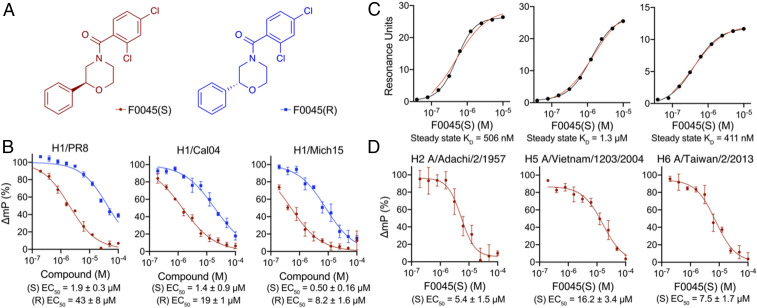
Characterization of F0045 enantiomers. (A) Chemical structures of F0045(S) and F0045(R). (B) Dose-response comparison (200 nM to 100 μM) of F0045(S) and F0045(R) binding a panel of H1 HAs as measured by the FP P7-TAMRA probe competition assay. The assay consisted of a solution of PBS, pH 7.4, 0.01% Triton X-100) and a 75-nM P7-TAMRA probe and H1 HA (30-nM H1/PR8, 30-nM H1/Cal04, and 100-nM H1/Mich15) mixed for several seconds at room temperature prior to measuring FP. DMSO and 300-nM P7 peptide represent the negative and positive controls, respectively. FP was measured in triplicate. (C) Steady state kinetic dose responses of F0045(S) (200 nM to 250 μM) against H1 HAs (H1/PR8, H1/Cal04, and H1/Mich15) as measured by SPR. (D) Dose-response comparison of F0045(S) binding a panel of group 1 HAs (50 nM for H2 A/Adachi/2/1957 and H5 A/Vietnam/1203/2004 and 55 nM for H6 A/Taiwan/2/2013) measured as in A.